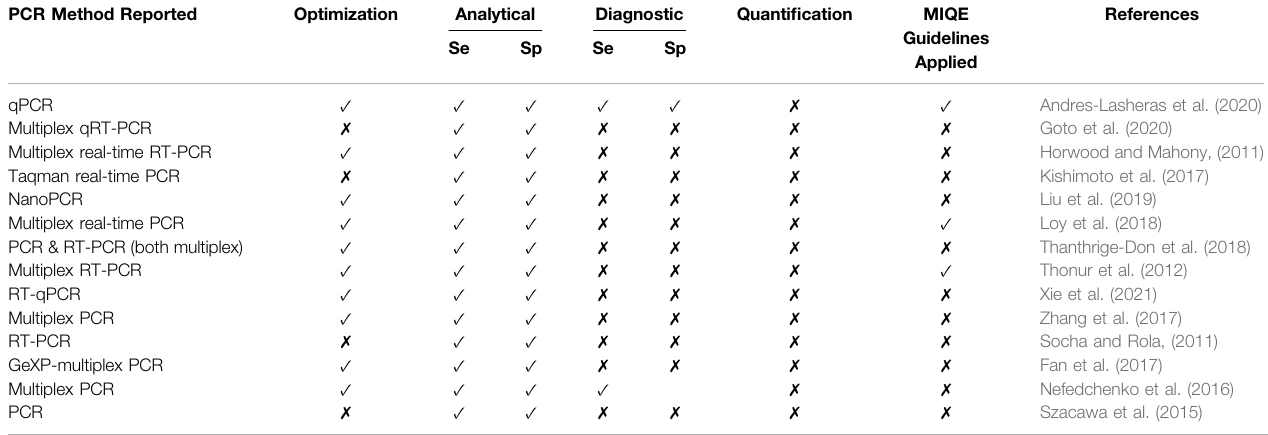
TABLE3| Reportingofoptimization,analyticalanddiagnosticsensitivityandspeci fi city,PCRmethod,quanti fi cationandMIQEguidelineapplication( Table2 ).Se,sensitivity; Sp, speci fi city. PCR Method